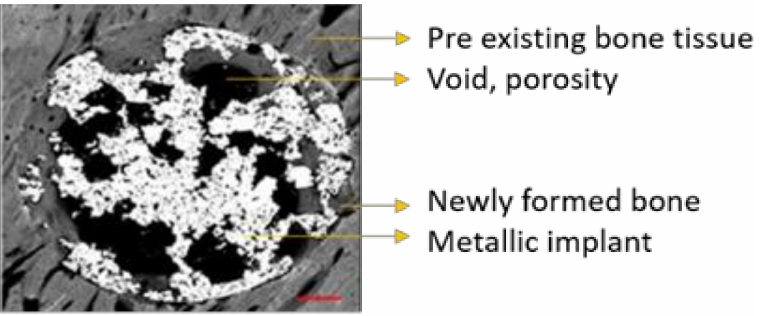
Figure 9. Stitched grayscale image obtained via SEM analysis detailing the different materials identified.